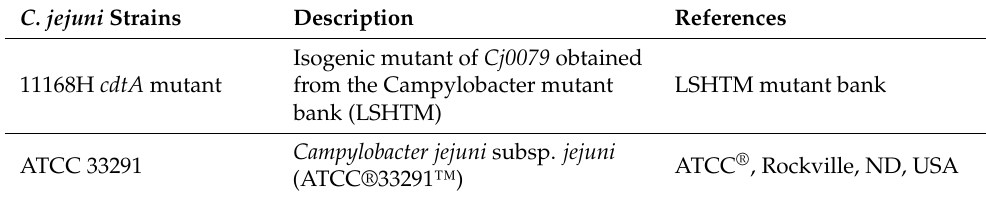
Table 1. Bacterial strain description and